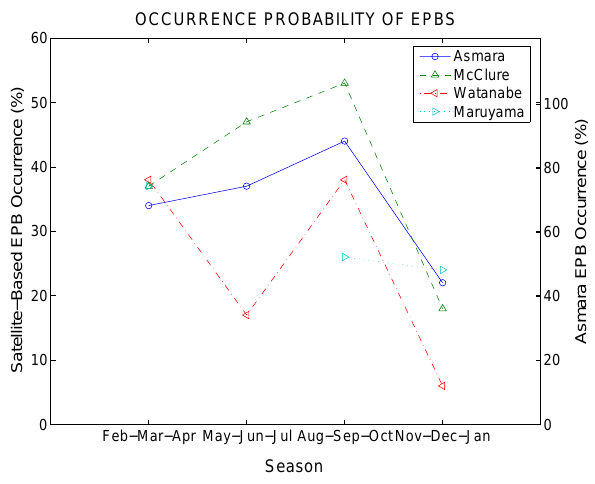
Fig. 10. Seasonal variation of occurrence probability of EPBs at 40 ◦ comparing Asmara with McClure et al. (1998), Watanabe and Oya (1986), and Maruyama and Matuura